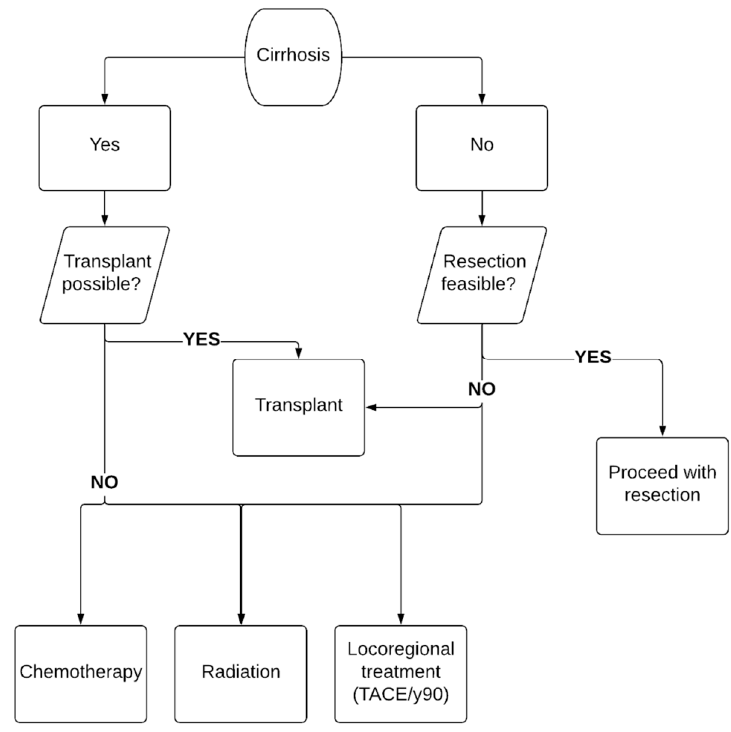
Figure 2. Approach to the management of cholangiocarcinoma.